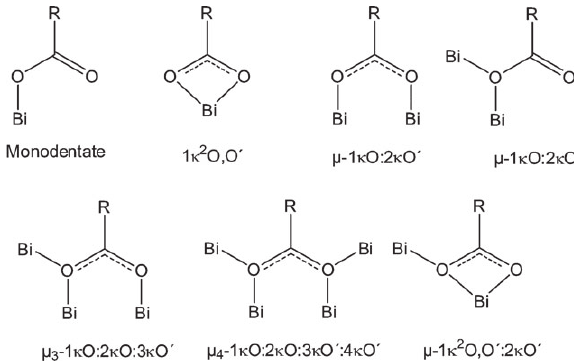
Scheme 1 Coordination modes of carboxylate ligands in clusters 1 and 2 .